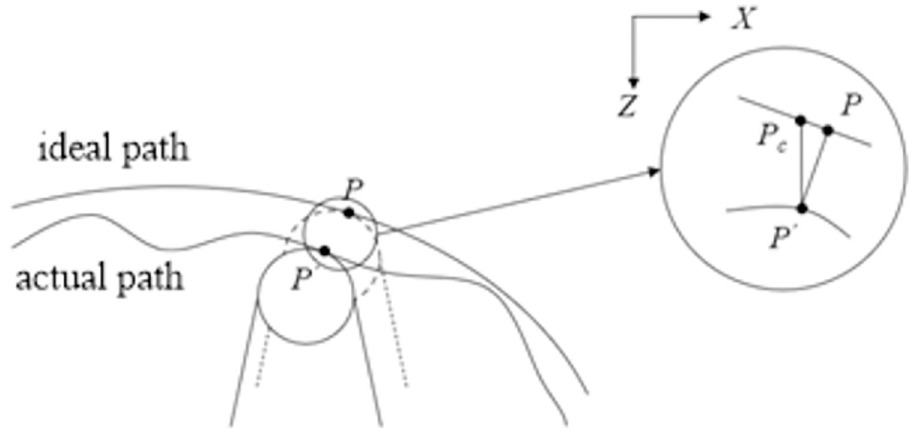
Fig 4. The diagram of tool path correction.